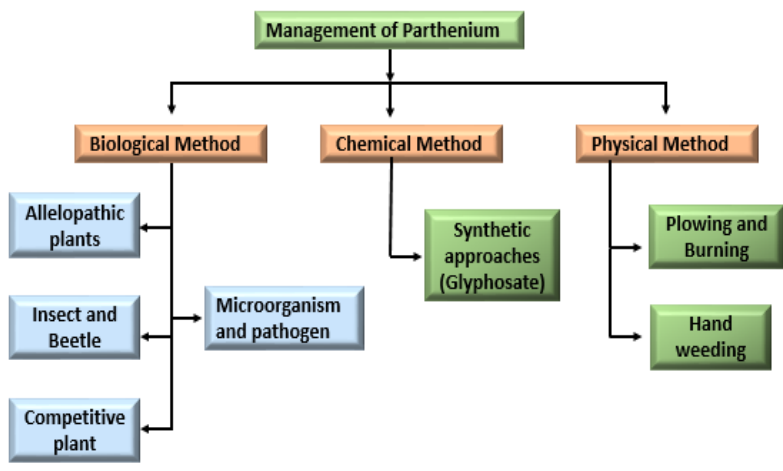
Figure 7. Schematic presentation of the management of Parthenium hysterophorus [27].